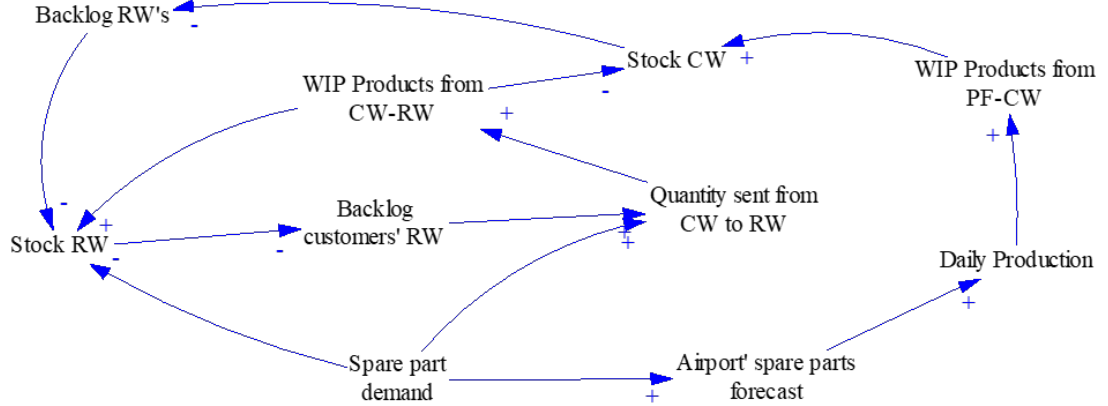
Figure 4. Casual loop diagram (CLD) for operational distribution (own elaboration).